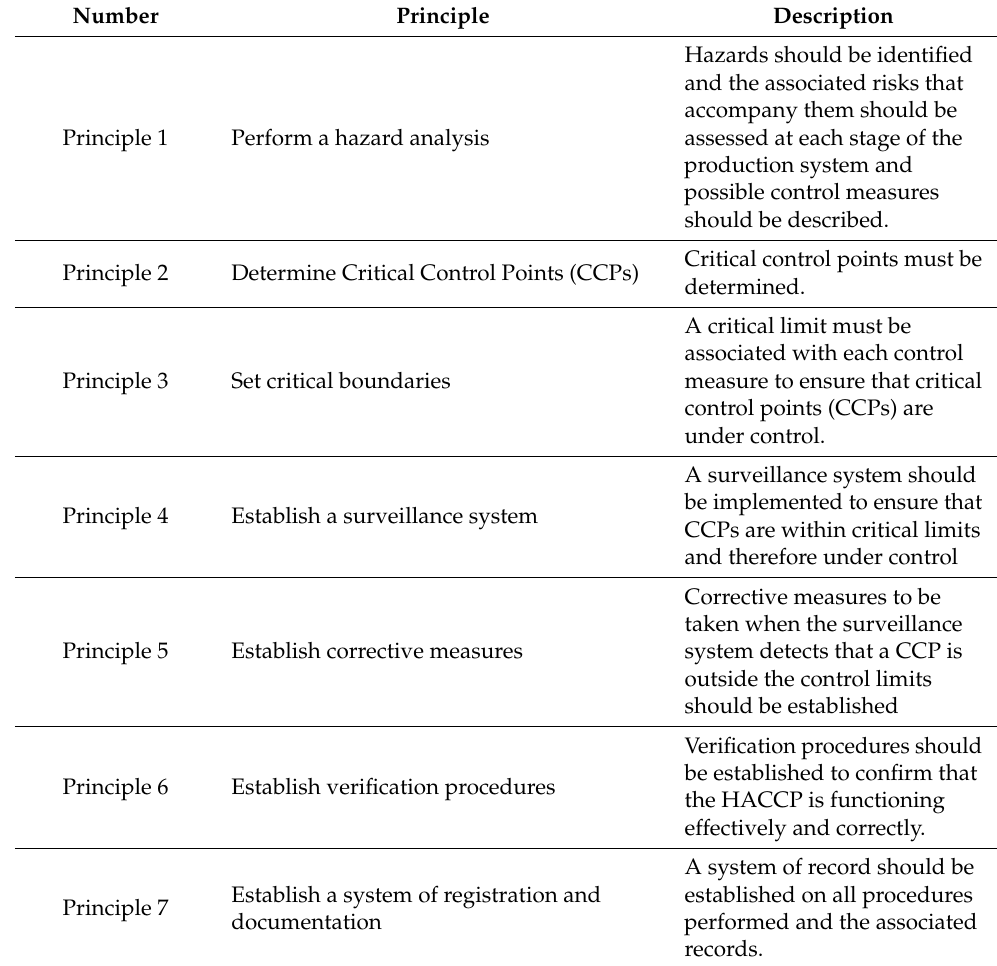
Table 1. Key principles of Critical Control Point Hazard Analysis